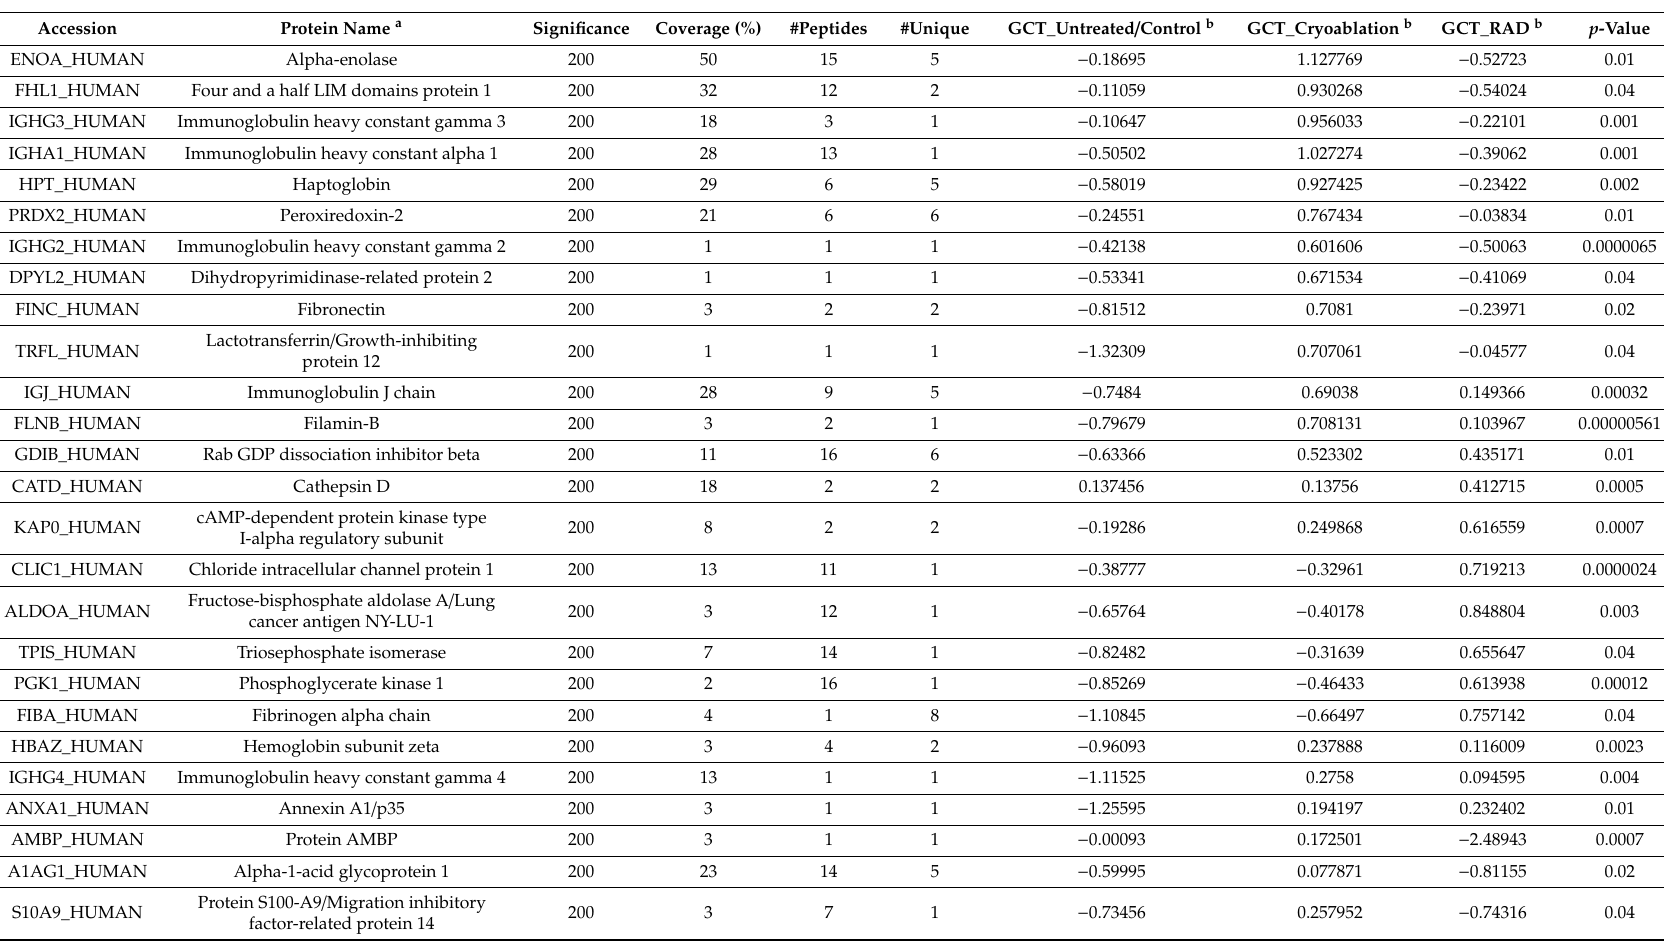
Table 2. Down-regulated proteins identified from untreated / control giant cell tumor of bone compared to cryoablation and irradiation